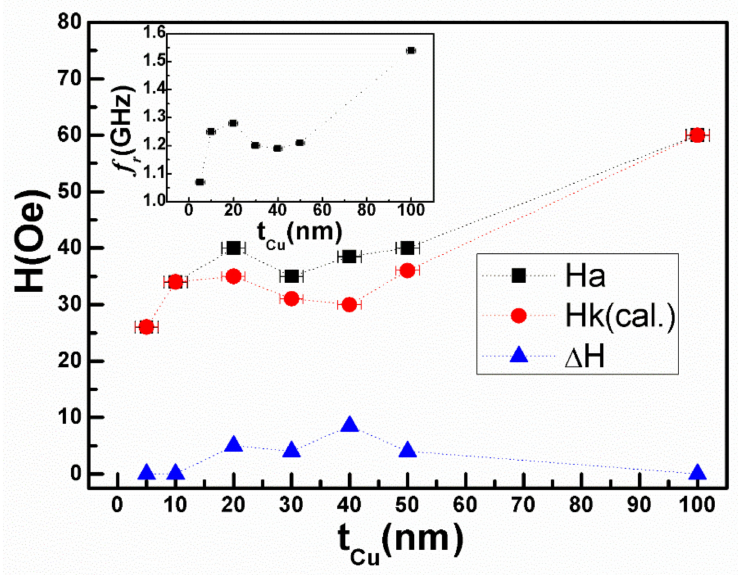
Figure 5. The IPUMA field H a , the effective IPUMA field H k and the difference ∆ H k (= H a − H k ) versus Cu underlayer thickness t Cu . The inset shows the resonance frequency f r versus t Cu .